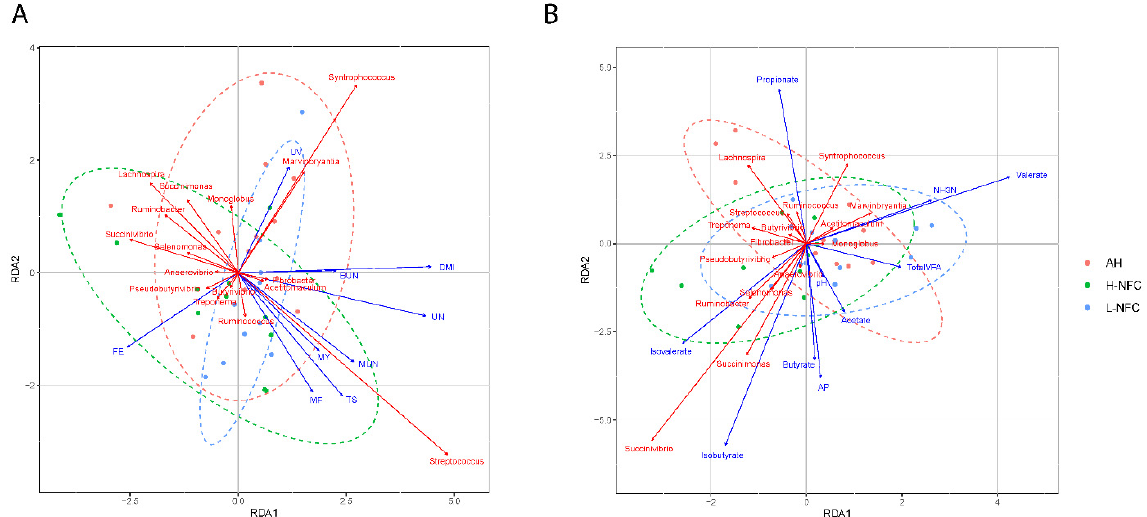
Figure 5. Canonical correlation analysis of microbial community relating to ( A ) physiological indexes and ( B ) rumen fermentation variables. The rumen fermentation variables and physiological indexes are indicated by solid blue lines, and the 15 differentially abundant genera are indicated by solid red lines. Samples collected from different dietary treatment groups are presented in different colors.